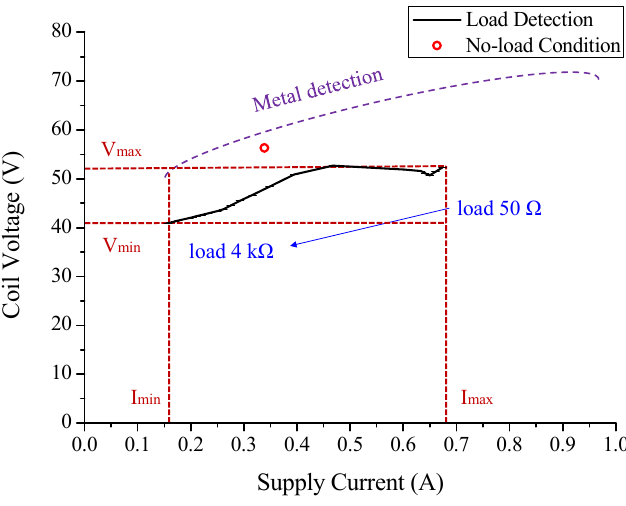
Figure 7. Measured result for different loading conditions on coil voltage and supply current.